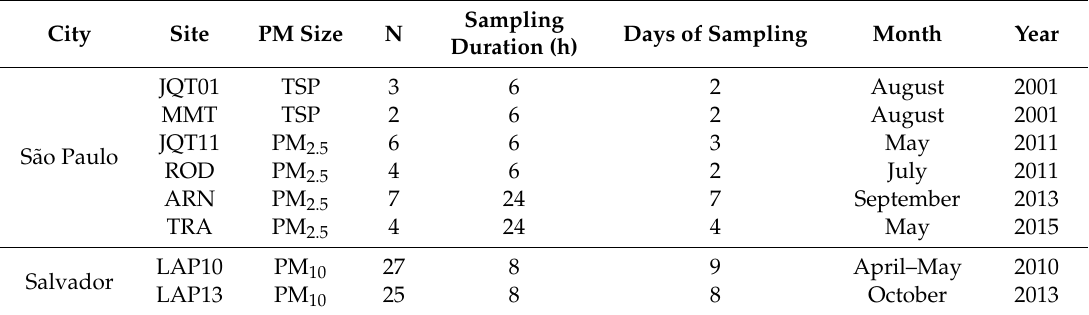
Table 1. City, particulate matter (PM) size, number of samples (N), sampling durations (in hours), number of sampling days, and months and years for each sampling